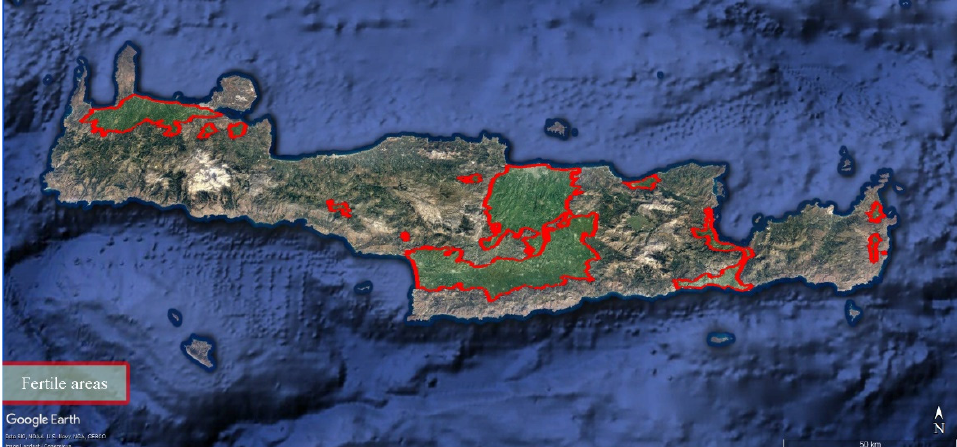
Figure 15. Limits of fertile areas in 2021, connected with Minoan settlements. Google earth [198] after adaptation.